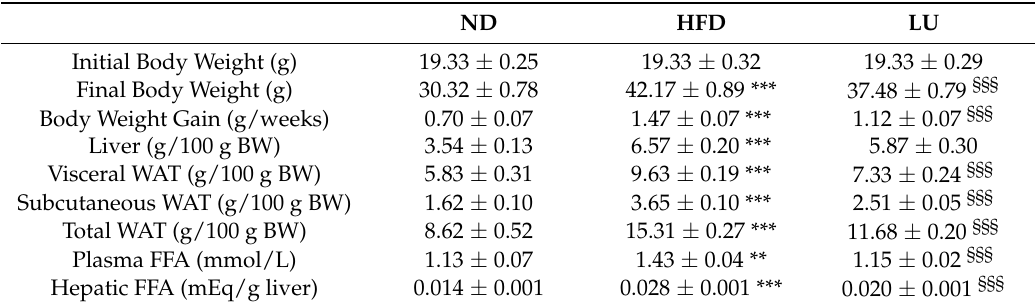
Table 1. Effect of luteolin treatment for 16 weeks on body and organ weights, and plasma and hepatic FFA levels in C57BL/6J mice fed the high-fat